Question: Condense the content of this figure into a single sentence.
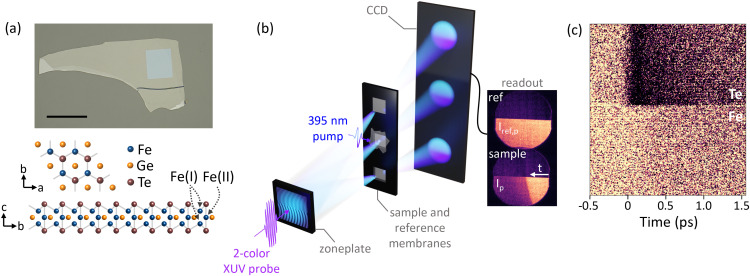
Answer: (a) Top: optical microscopy image of the FGT sample on a Si 3 N 4 membrane used in the static absorption spectra (50 μ m scale bar). Bottom: top and side views of the crystal structure of FGT, showing Fe and Ge sandwiched between Te layers. There are two inequivalent sites, Fe(I) and Fe(II), in the intermediate and center layers, respectively. (b) Simplified schematic of the zone plate streaking setup. An off-axis zone plate optimized for two photon energies (with a ratio of 15:11) is used to diffract a two-color XUV probe pulse. In addition, a perpendicular grating (included in the zone plate design) creates several copies of the focus, 35 which pass through the sample and reference membranes. The path length difference between rays of the probe diffracted at different rings of the zone plate introduces an intrinsic time delay into the probe. A pump pulse ( λ = 395 nm ) is synchronized to hit the sample simultaneously with part of the probe. The diverging probe beams are then imaged with a CCD behind the sample. In the recorded image, one axis contains time-resolved information (marked with t in the readout image). The same measurement provides a signal through the sample and a reference signal (ref) for normalization. (c) Processed image measuring absorption dynamics at the Fe M 2 , 3 ( E = 55.02 eV , bottom half) and Te N 4 , 5 ( E = 40.35 eV , top half) edges. The signal is then integrated along the y-axis in each half.